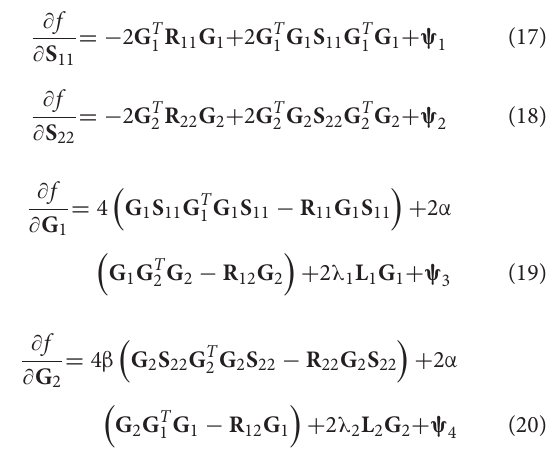
Based on the NetNMF and the graph-regularized constraint, the objective function of the NMFNA is defined